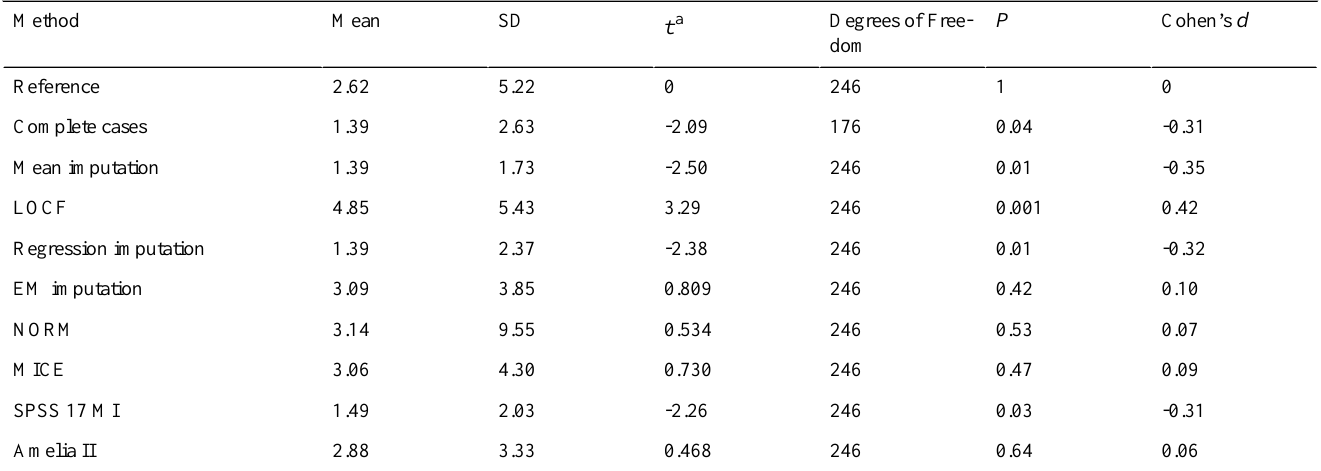
Table 2. Independent samples t tests for missing data approaches against reference